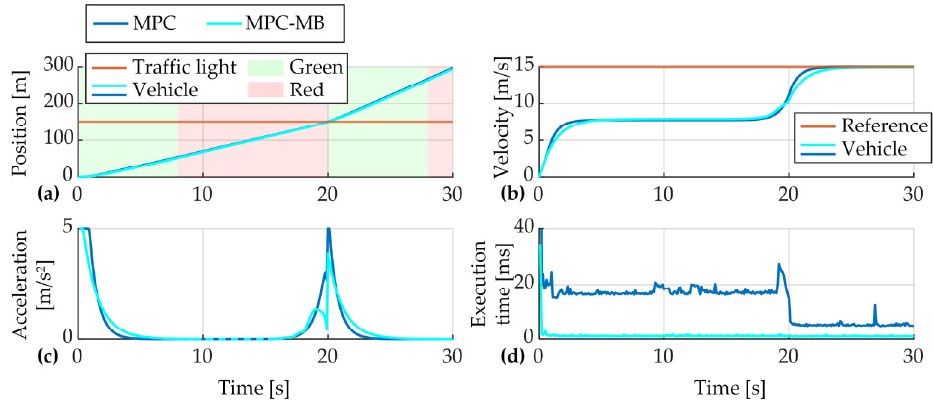
Figure 9. Comparative responses position ( a ), velocity ( b ), acceleration ( c ) and execution time ( d ) of nominal and move-blocking (MB) linear MPC systems.